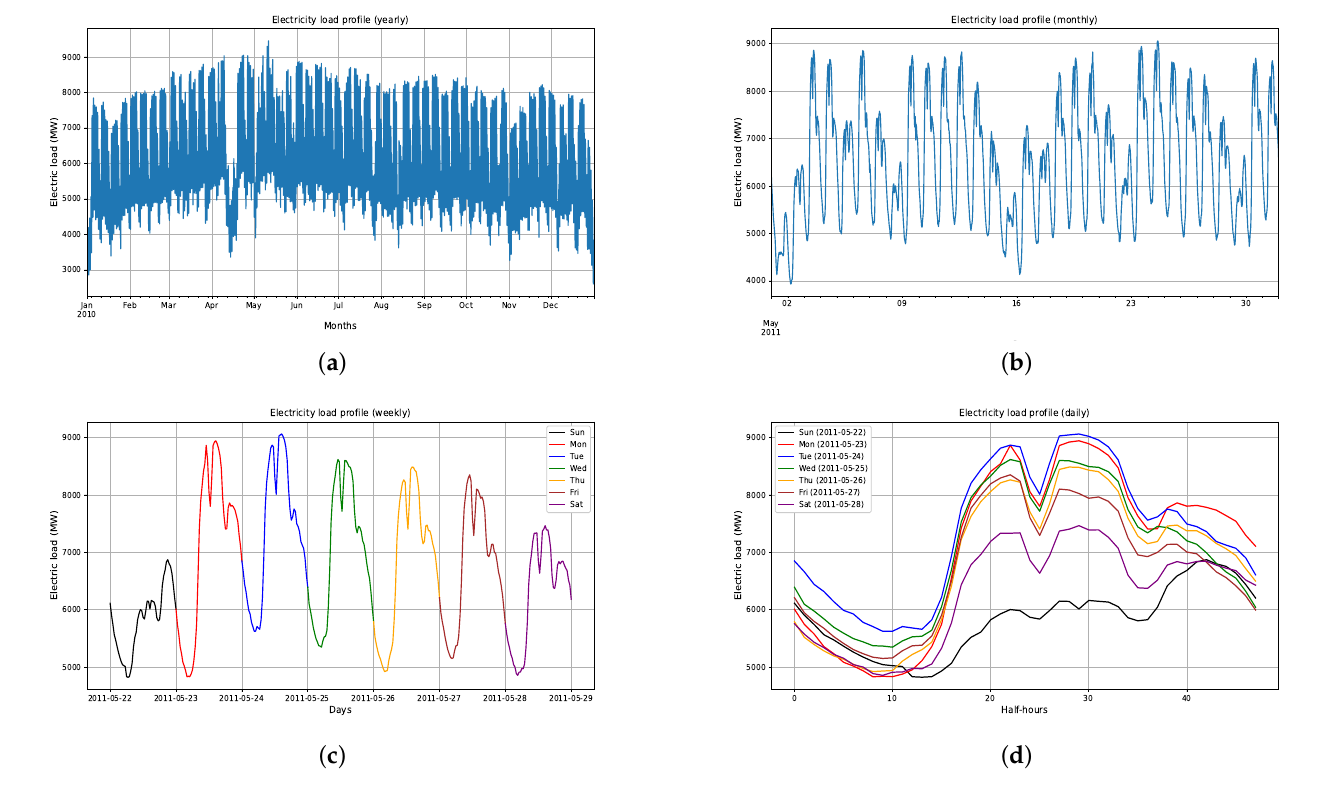
Figure 5. ( a ) Monthly variation in electric load for the year 2010. ( b ) Weekly variation in electric load for May 2011. ( c ) Daily variation in electric load for the period 22–28 May 2011. ( d ) Daily load curves (half-hourly variation) for the period 22–28 May